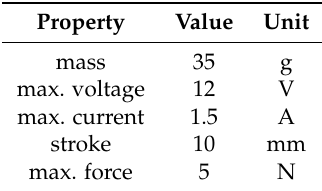
Table 1. Properties of the solenoid.